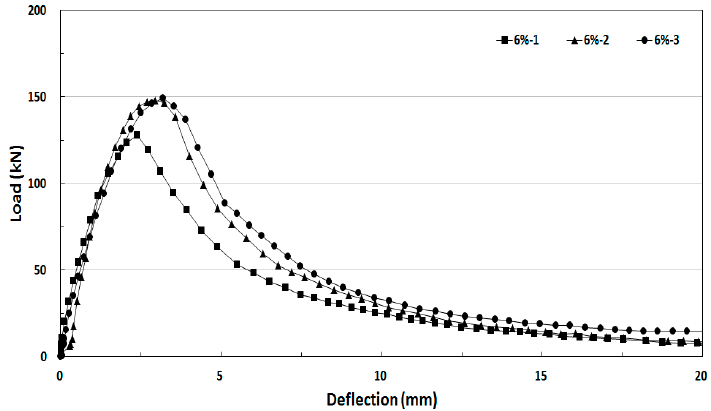
Figure 3. Load-mid span deflection curve at a fiber volume fraction of 6%.